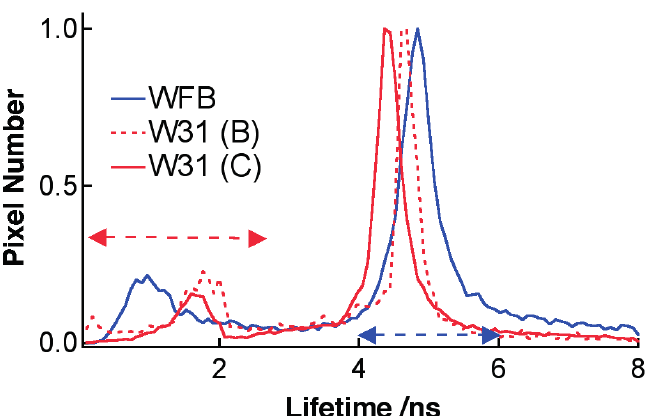
Figure 6. Histograms of the average fluorescence lifetime of TPS in WFB (blue) and W31 (red) cells. Red broken line and red solid line correspond to the images shown in Figure 4B and C, respectively.